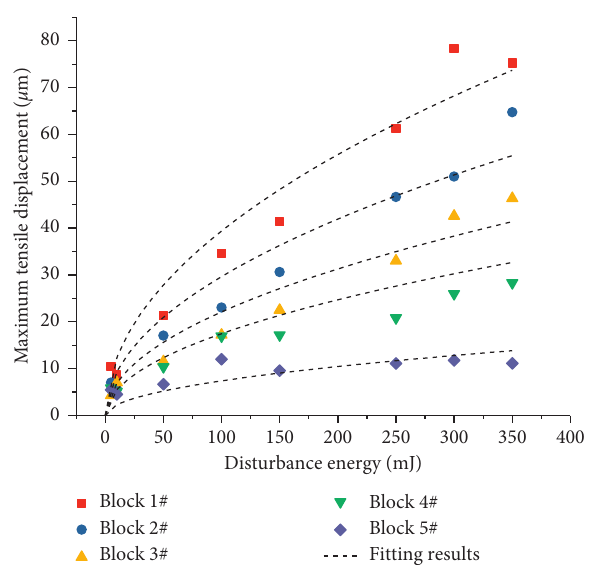
Figure 5: Relations between the maximum tensile displacements and disturbance energies.